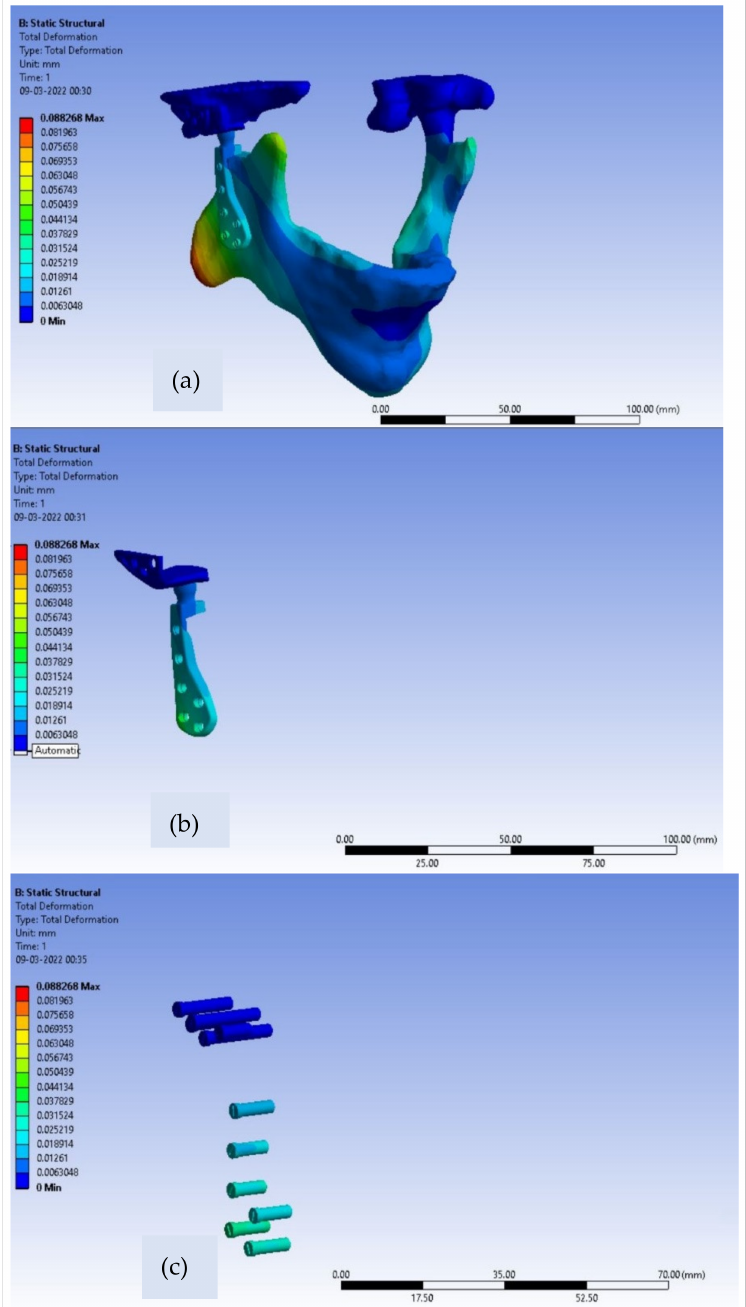
Figure 9. Deformation contours for ( a ) Total TMJ prostheses with mandible ( b ) Condylar and fossa parts without screws ( c ) fossa and condylar screws in case of Co-Cr alloy model of customized TMJ